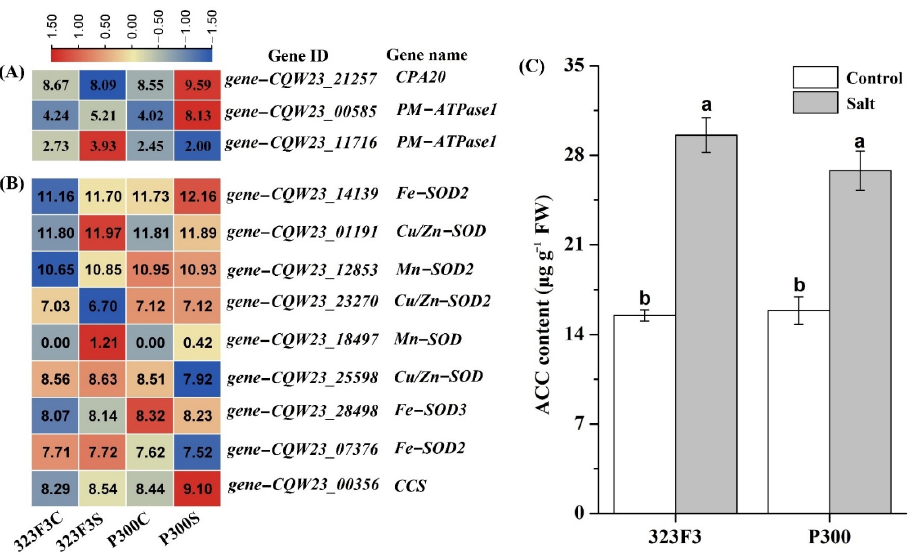
Figure 10. Heatmap analysis of the gene expressions and ACC content comparisons in 323F3 and P300. ( A ) The genes encoding SOD-type proteins and copper chaperone for SOD (CCS). ( B ) The DEGs involved in SOS pathway in the 323F3C vs. 323F3S and P300c vs. P300S comparisons. Log2 (read counts + 1) of each gene in different samples are shown in the heatmaps and the values of each gene in different samples were scaled by normalization using Tbtools software. ( C ) ACC content determination in 323F3 and P300 under control and salt conditions. Different small letters represent significant differences at p < 0.05 according to one-way